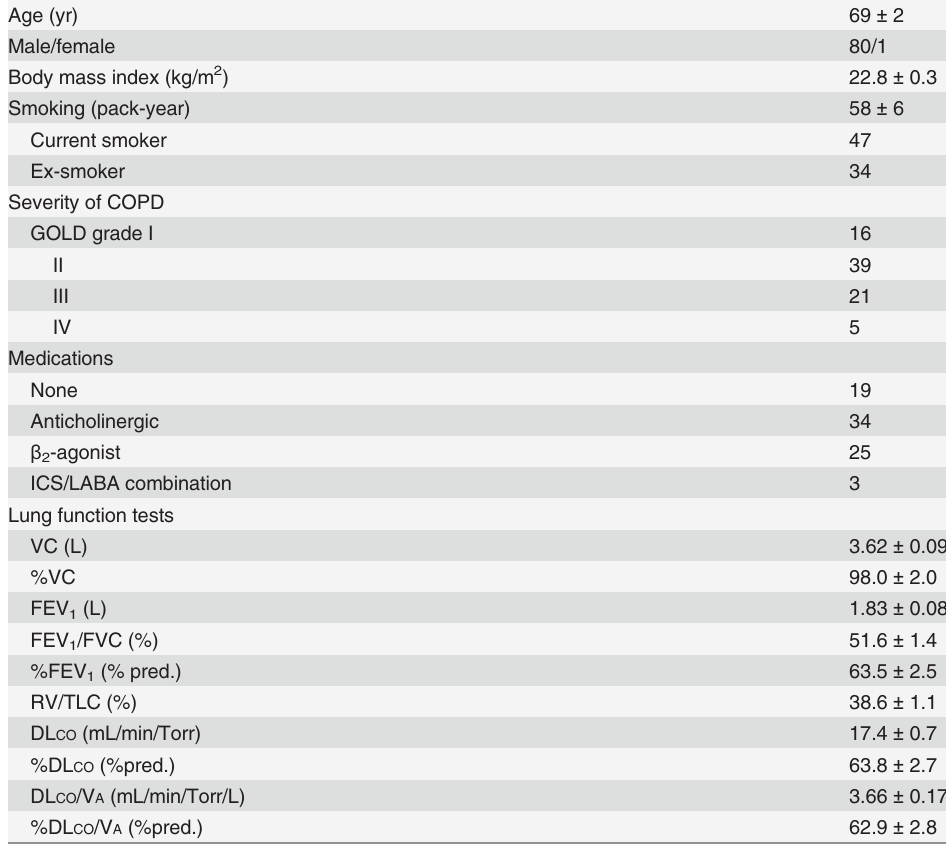
Table 1. Baseline demographic and physiological